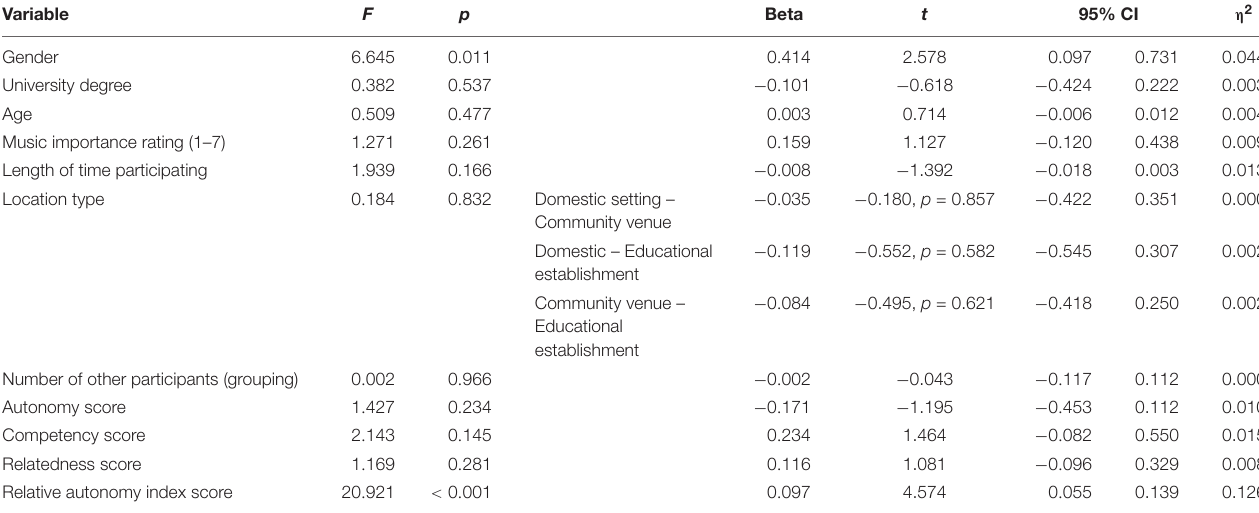
TABLE 7 | Self-actualization well-being score model.